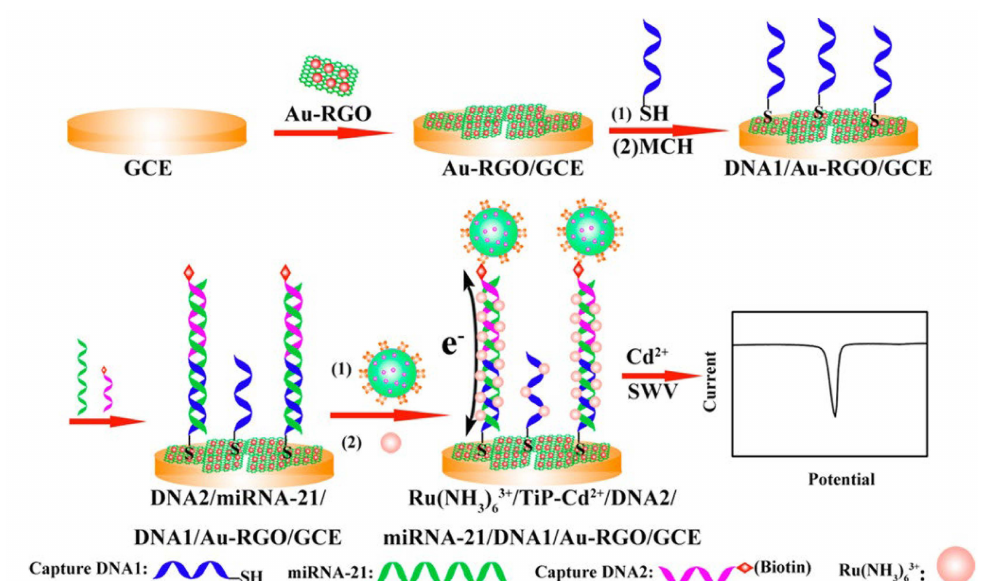
Figure 3. Modification of the GCE electrode surface with nanomaterials and experimental steps related to sandwich type detection. Reprinted with permission from Ref. [85]. Copyright 2015, American Chemical